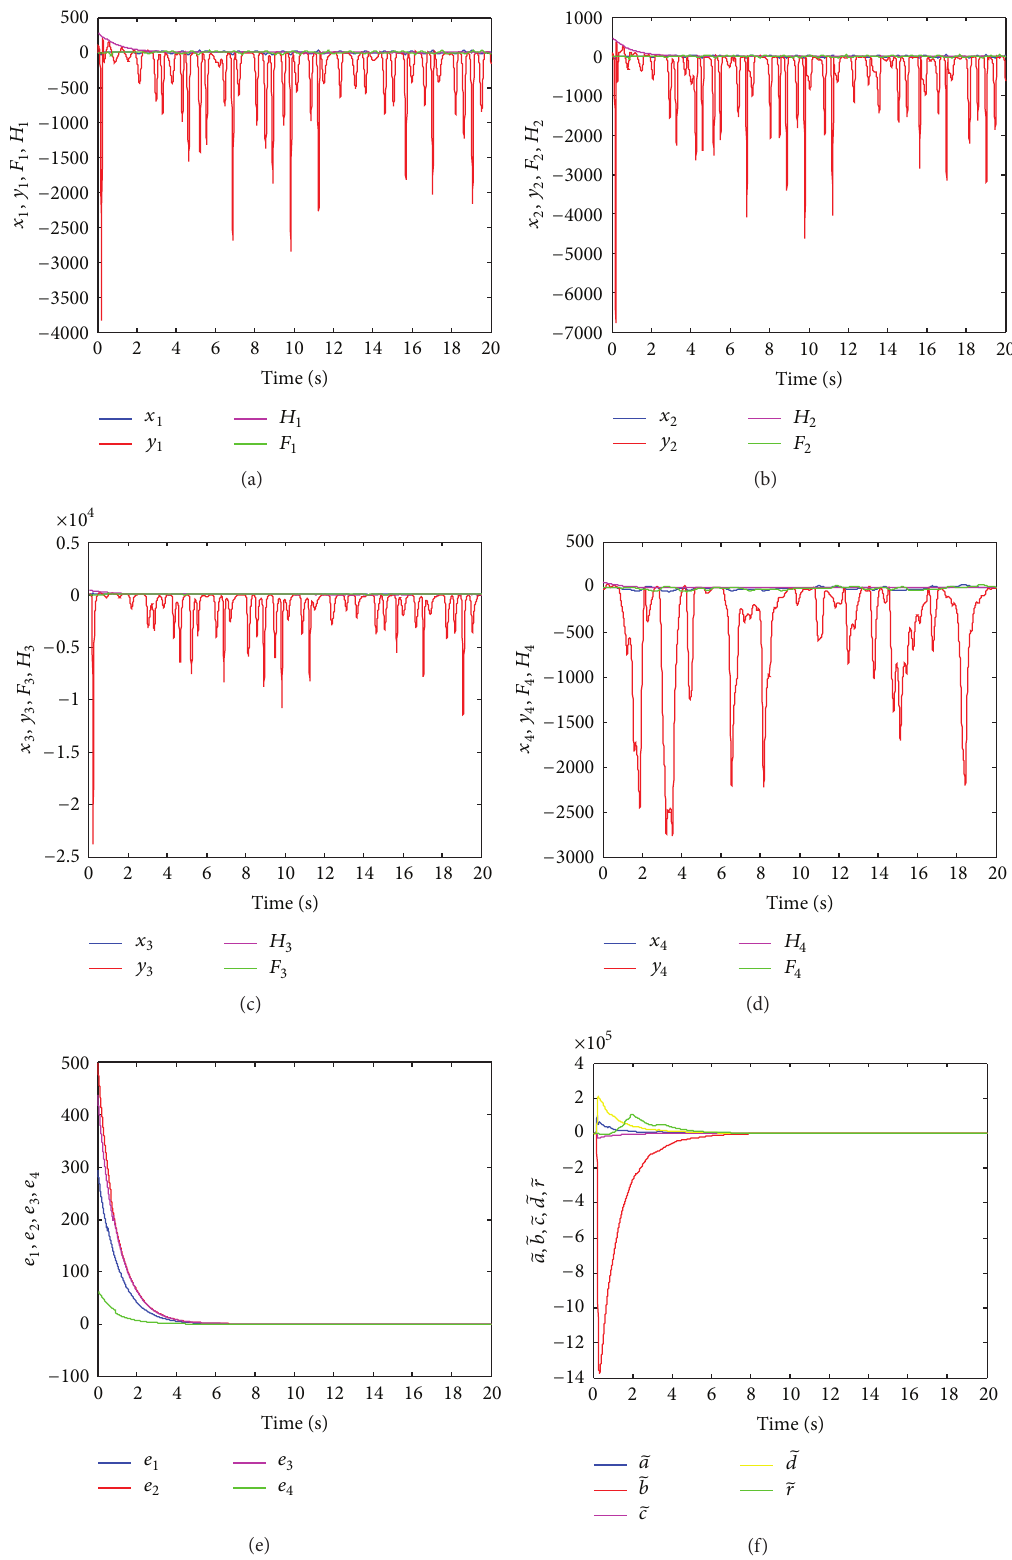
Figure 9: Time histories of states, state errors, parameter differences, 𝐹 1 , 𝐹 2 , 𝐹 3 , 𝐹 4 , 𝐻 1 , 𝐻 2 , 𝐻 3 , and 𝐻 4 for Case